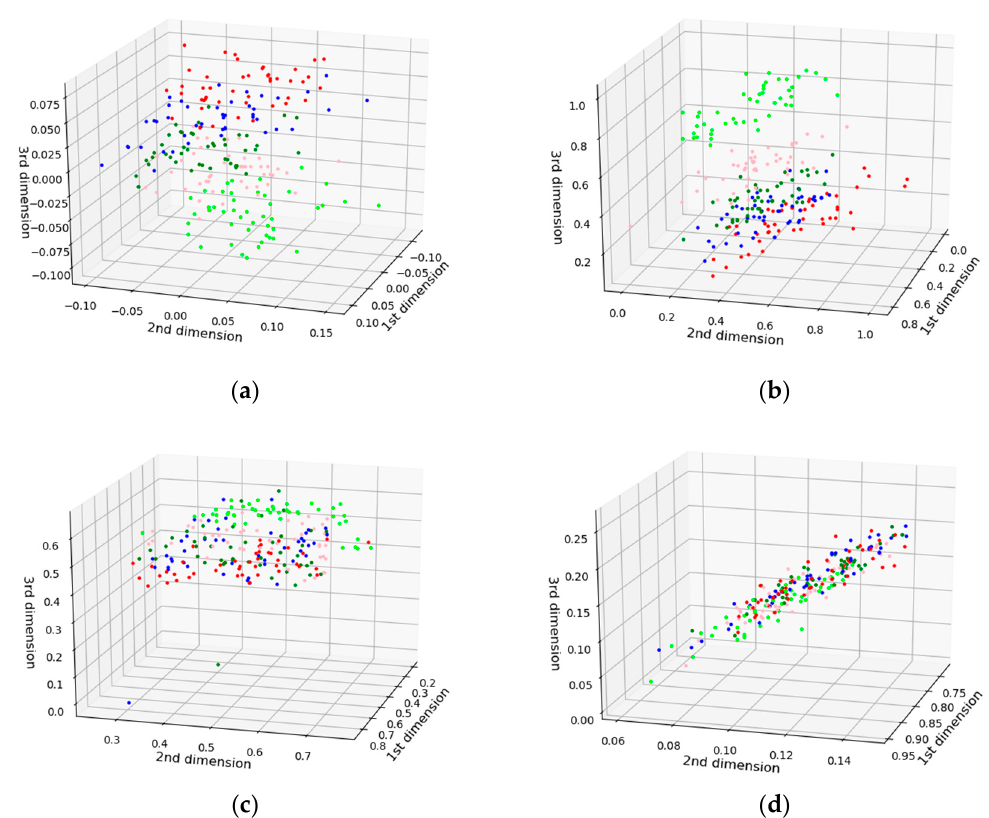
Figure 9. Clustering effect of the first three dimensions of four comparison algorithms (lime green, light pink, green, blue, and red represent 0, 10, 20, 50, and 100 ppb, respectively). ( a ) ICA, ( b ) FA, ( c ) t-SNE, ( d ) RP.